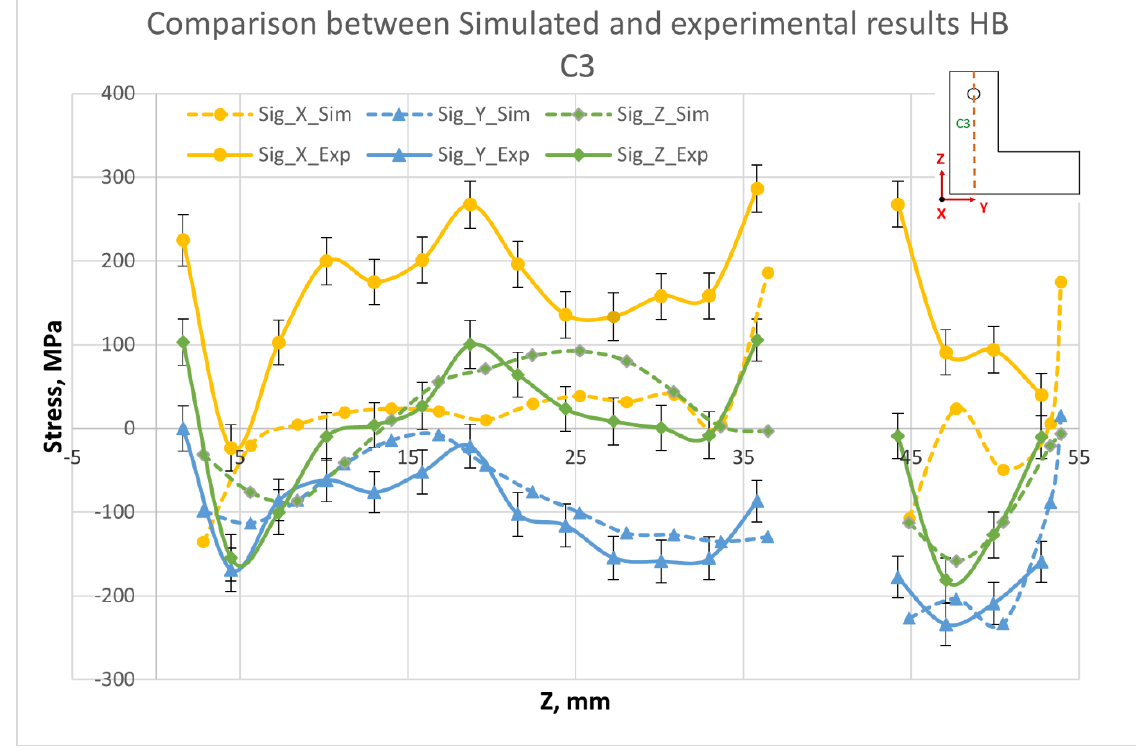
Figure 20. Comparison between experiment and simulation results for HB sample cross-section C3.